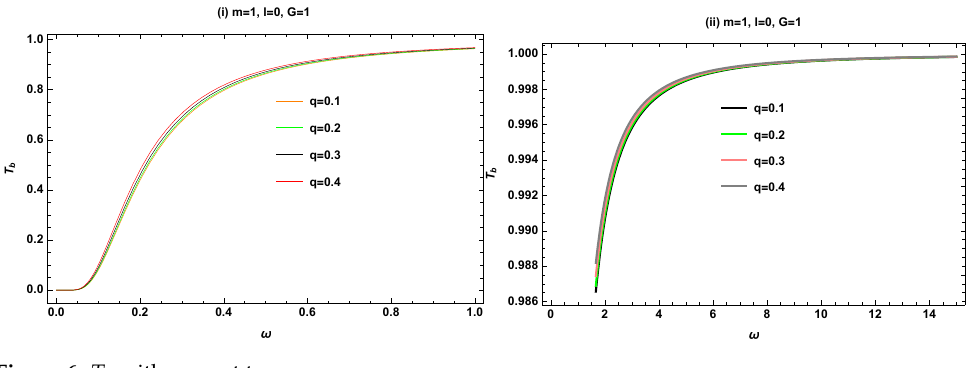
Figure 2: T b with respect to ω . 199 Figure 6. T b with respect to ω